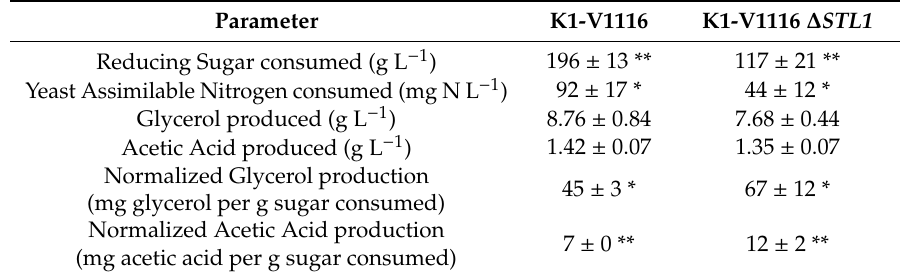
Table 1. Icewine juice and final wine chemical composition. Data represent the mean value ± standard deviation from triplicate fermentations, with each sample tested in duplicate. Lowercase letters within the same parameter indicate differences between treatments as tested by ANOVA, with mean separation by Tukey’s Honest Significant Difference (HSD 0.05 ).